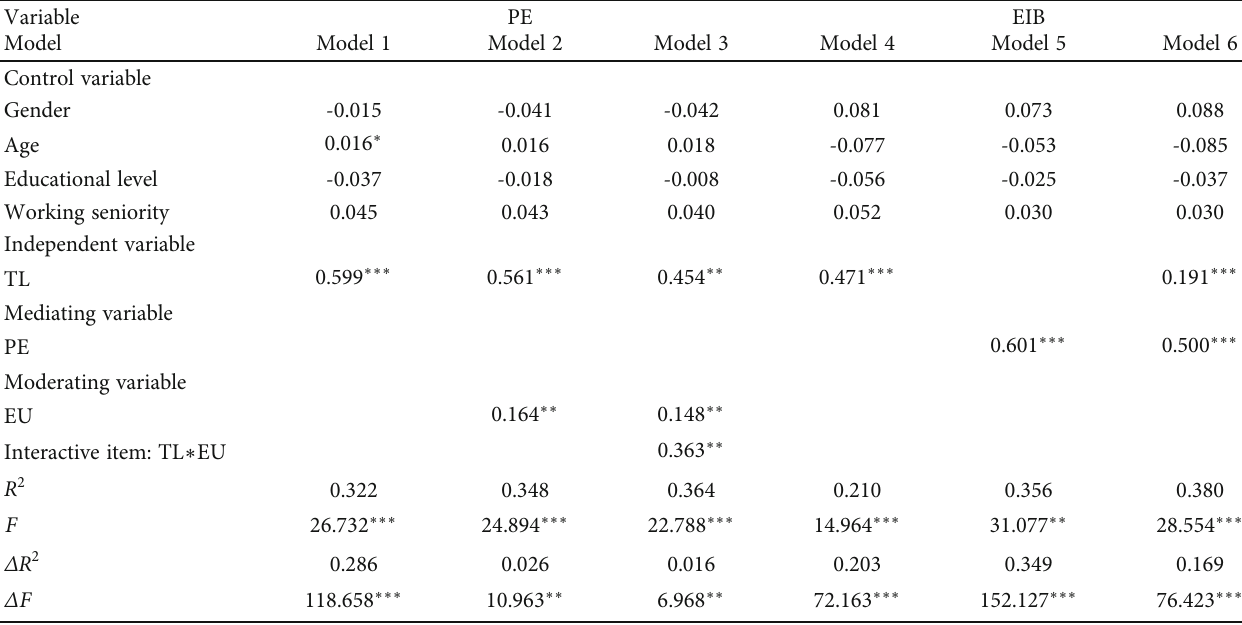
Table 3: Hypothesis test results by hierarchical regression analysis.